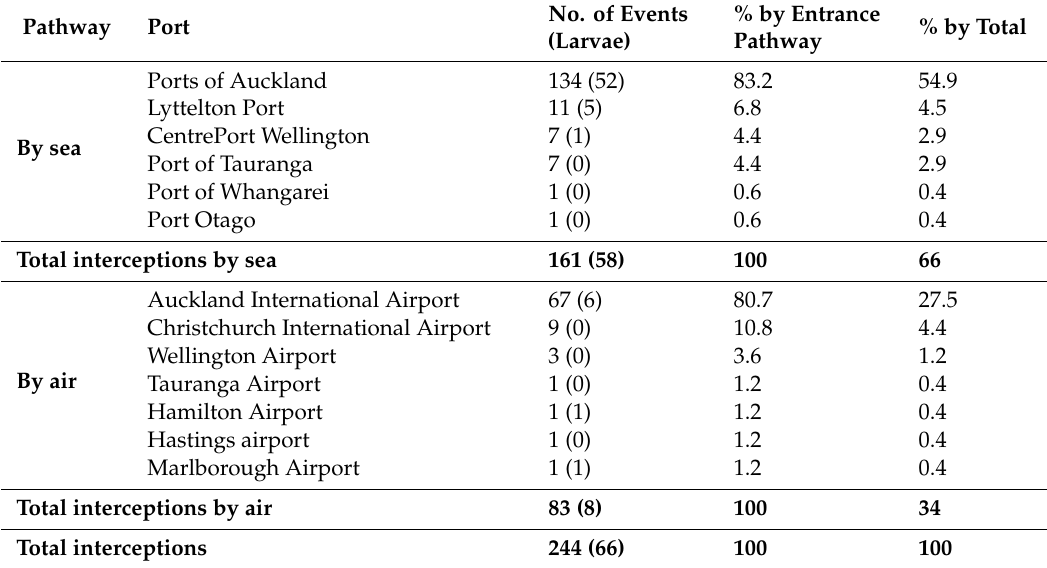
Table 3. Entrance pathway and development stages of mosquito interception events in New Zealand, July 2001–March 2018.